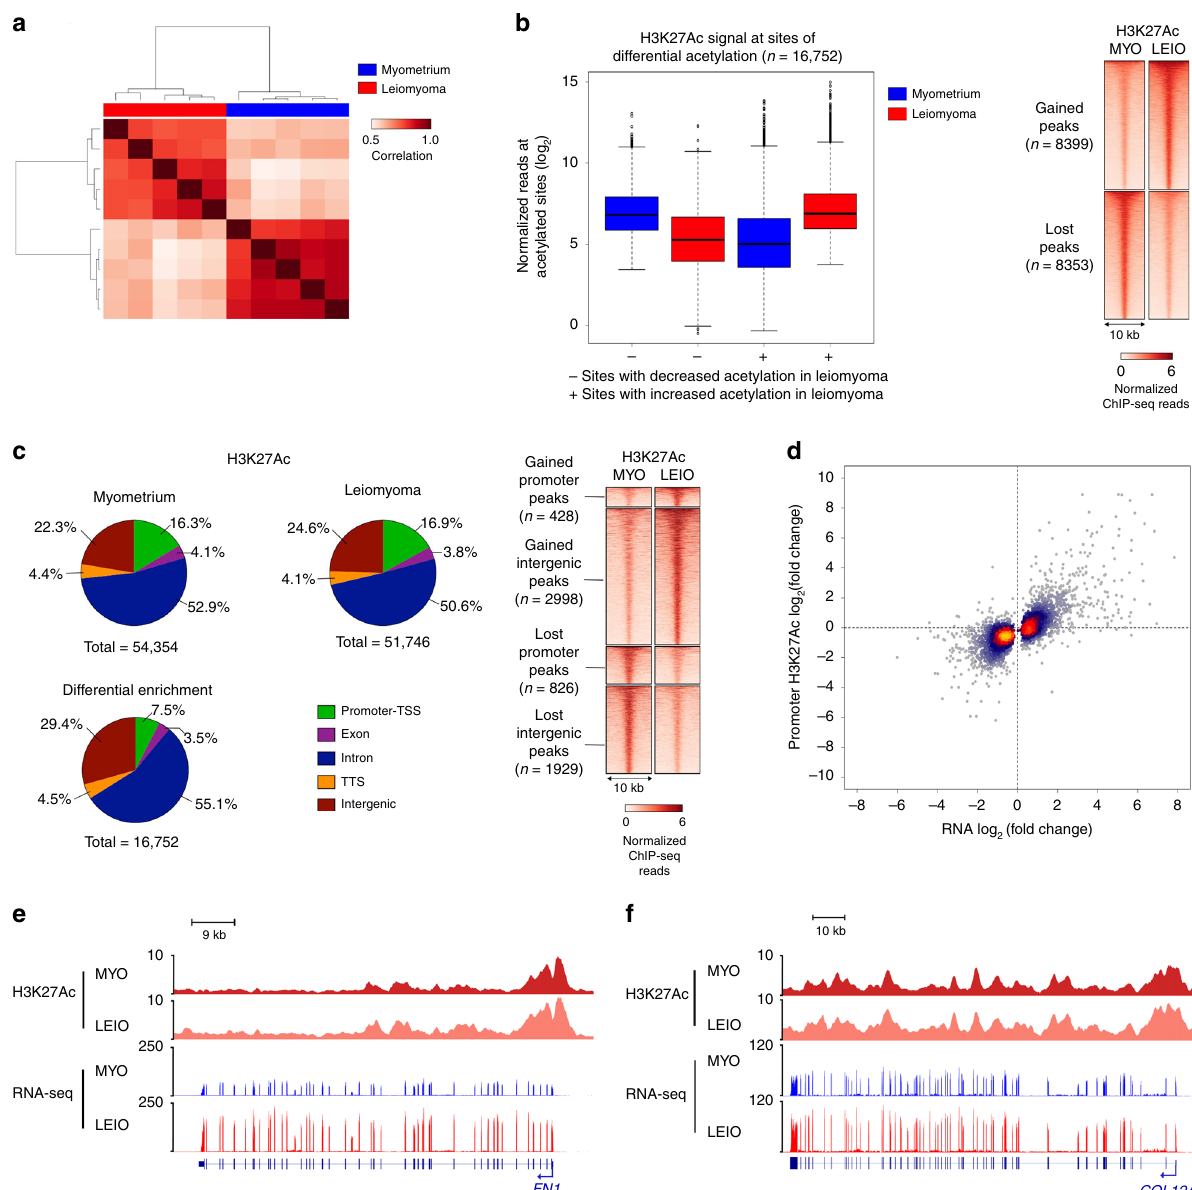
Fig. 2 Histone acetylation changes occur disproportionately at intergenic regions. a Correlation (Pearson ’ s) heat map of H3K27Ac ChIP sample af fi nity scores obtained from myometrium (blue) and leiomyoma (red) ChIP-seq read counts. b Box and whisker plot of normalized reads at differentially acetylated sites in myometrium and leiomyoma (left panel). Plots of sites with decreased H3K27Ac signal ( − ) and increased signal ( + ) are shown separately. Centerline represents the median, bounds of box represent the interquartile range (IQR) and whiskers are 1.5×IQR. Right panel shows a heat map of normalized H3K27Ac ChIP-seq reads at differentially acetylated regions in myometrium vs. leiomyoma. Heat map represents average signal of fi ve biological replicates. c Pie charts of H3K27Ac signal distribution at genomic loci in myometrium (top left of left panel), leiomyoma (top right of left panel) and at differentially acetylated regions (bottom left of left panel). Right panel represents heat map of normalized H3K27Ac ChIP-seq reads at gene promoters and intergenic loci with differential H3K27Ac signal. Heat map represents average signal of fi ve biological replicates. d Heat scatter plot of fold change in H3K27Ac signal against fold change in gene expression at promoters of differentially expressed genes ( n = 3559). e , f Unchanged H3K27Ac signal in myometrium (red) and leiomyoma (salmon) at FN1 ( e ) and COL12A1 ( f ) genes. Normalized RNA reads for myometrium (blue) and leiomyoma (red) are also